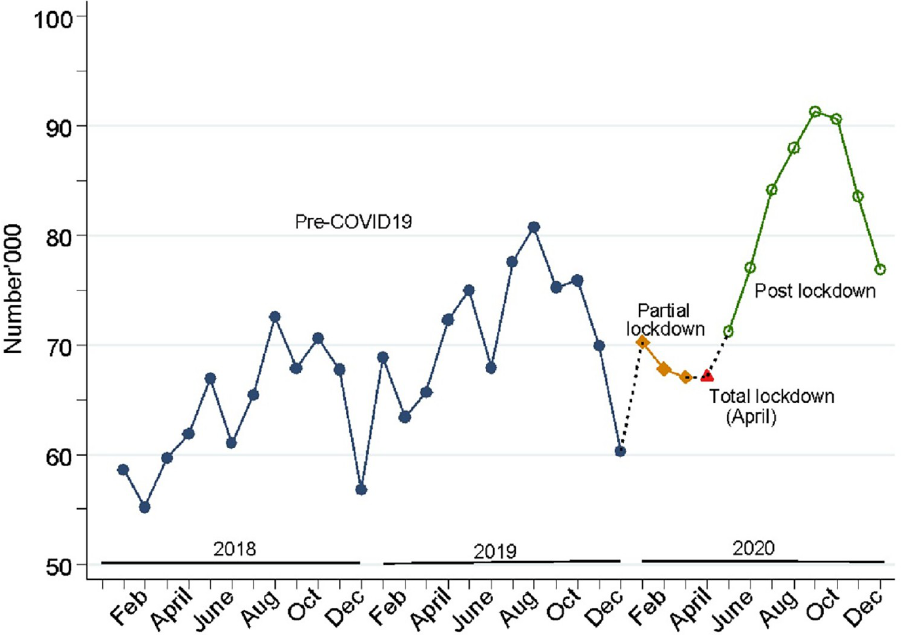
Fig 2. Trends in monthly total number of ANC4+ visits in Uganda, from 2018 to 2020.